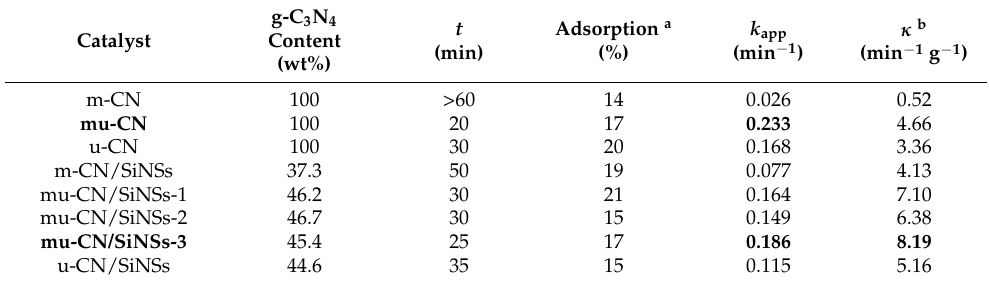
Table 3. Photocatalytic performance of the CNs and CN/SiNSs composites towards RhB degradation.